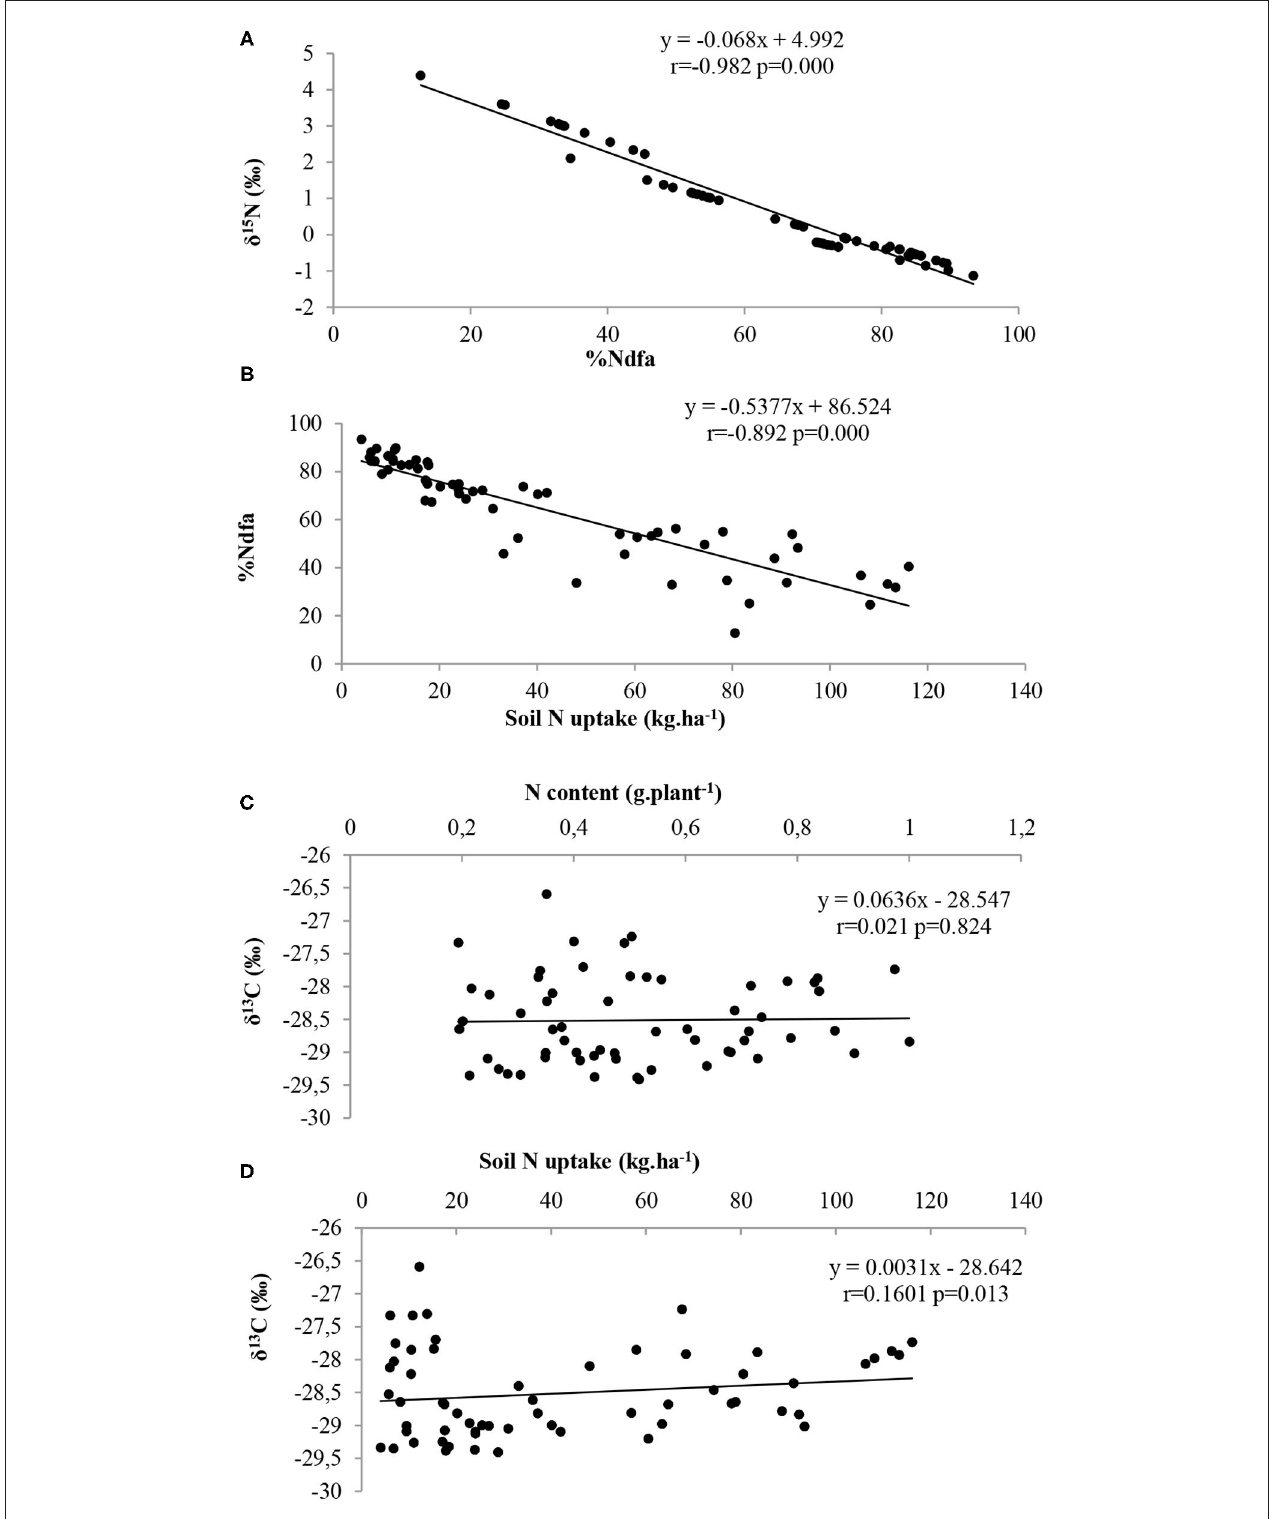
FIGURE 4 | Relationships between (A) %Ndfa from ureide-N and δ 15 N, (B) %Ndfa and soil N uptake, (C) δ 13 C and shoot N content, and (D) δ 13 C and soil N uptake (D) of Bambara groundnut landrace at flowering at 56 DAP.